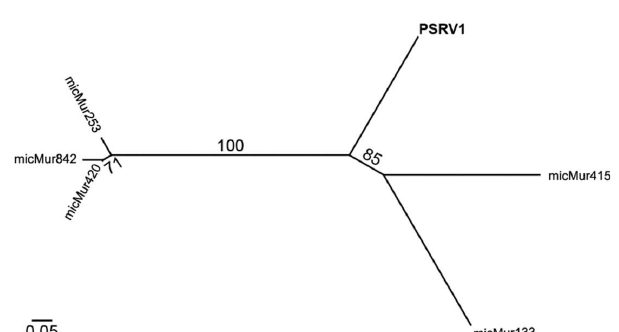
Figure 3. Phylogeny of PSRV1 and partial retrovirus sequences identified in gray mouse lemur genome. ( A ) Phylogenies generated by maximum likelihood of pol gene nucleotide sequence alignment of PSRV1 and alignable retrovirus sequences identified in Hayward et al. [21]. The endogenous retrovirus (ERV) with the highest nucleotide identity to PSRV1 was a region in the pol gene from micMur415 sharing 57.78% identity. Scale indicates bootstrap values.